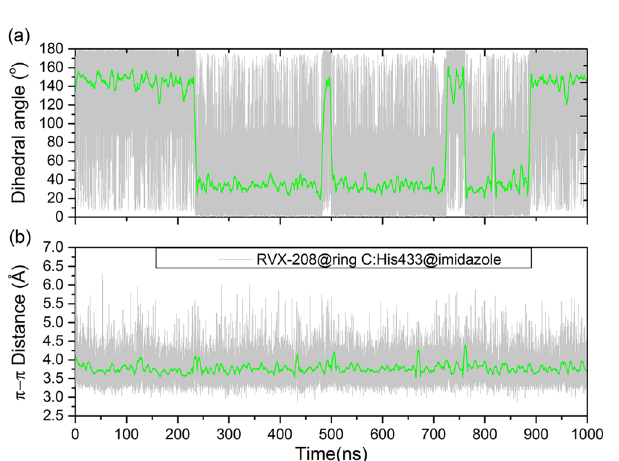
Figure 8. Binding mode of RVX-208 with ( a ) BRD2-BD1 and ( b ) BRD2-BD2. Green and blue dash lines are indicative of hydrogen bonds and π - π stacking interaction, respectively.